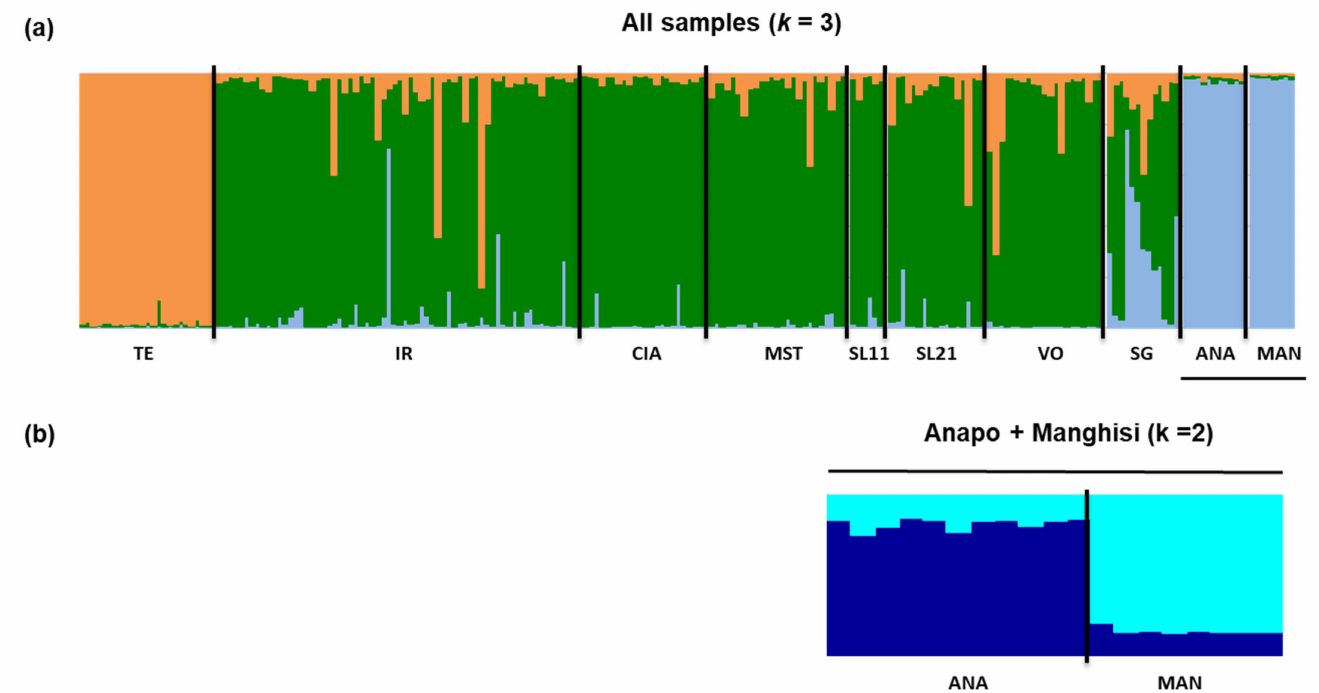
Figure 3. Admixture analyses by STRUCTURE ( a ) at the highest level of hierarchy ( k = 3) and ( b ) at the low level of hierarchy (Manghisi + Anapo k = 2; all samples k = 4). Each individual is represented as a vertical bar partitioned into segments according to the proportion of the genome belonging to each of the clusters identified ( k